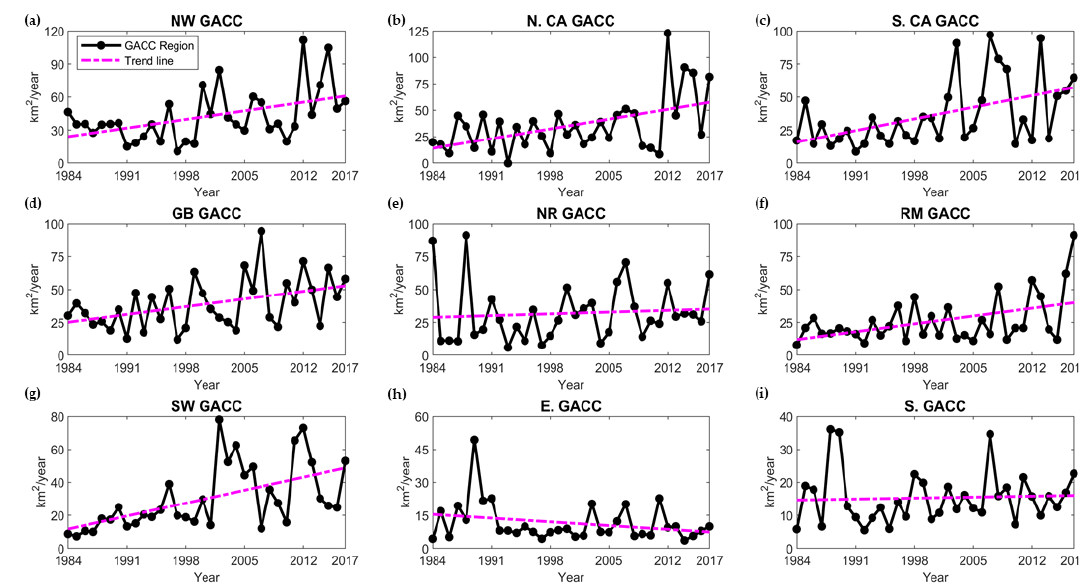
Figure 5. ( a – i ) Time series of the nine GACC regions (1984–2017) for the parameter of average burned area per year. Each time series is fitted with a trend line, in purple, using linear regression techniques (least-squares method).